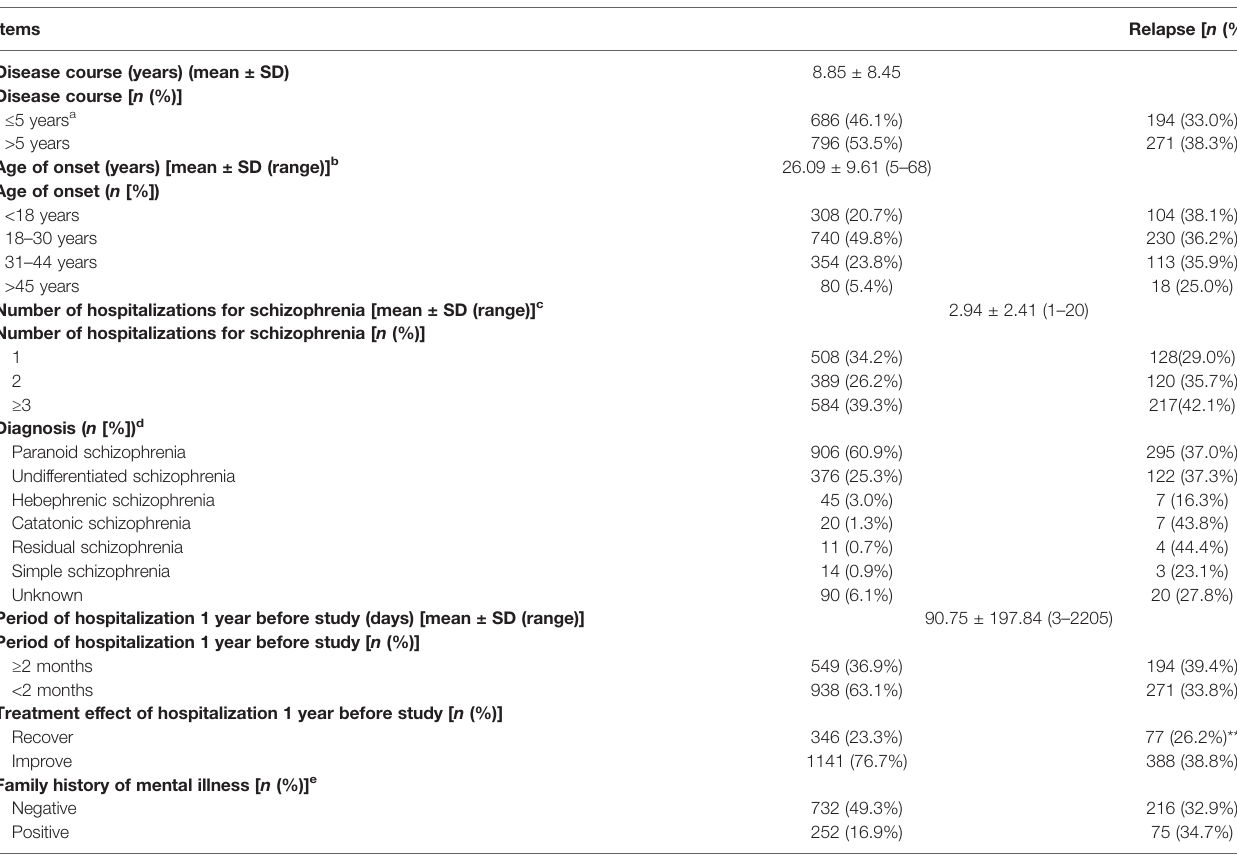
TABLE 1-2 | General demographic and disease information of the patients ( n = 1487).